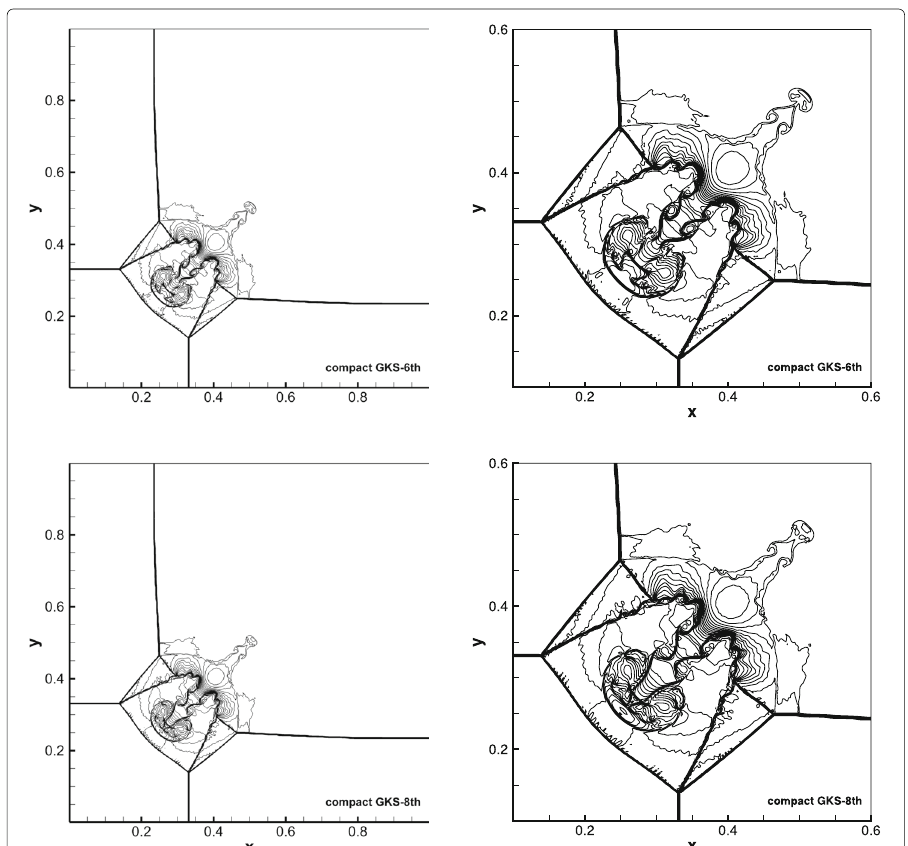
Fig. 15 2D Riemann problem: the density distributions by 6th-order and 8th-order compact GKS for the interaction of four shock waves at t = 0.4 with 500 × 500 mesh points